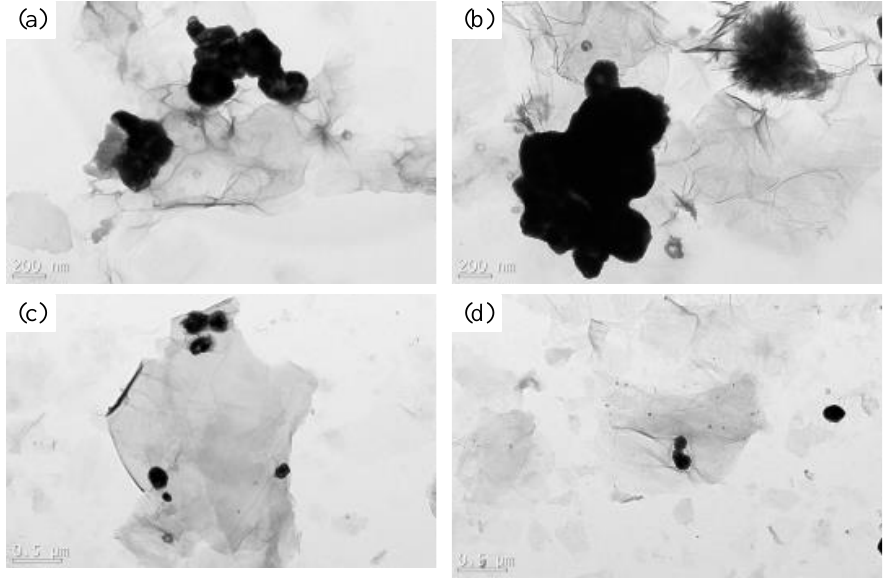
Figure 3. TEM images of biochar and BG composites at 300 ◦ C and 600 ◦ C ( a ) B 300 ; ( b ) B 600 ; ( c ) BG 300 ; ( d ) BG 600 .